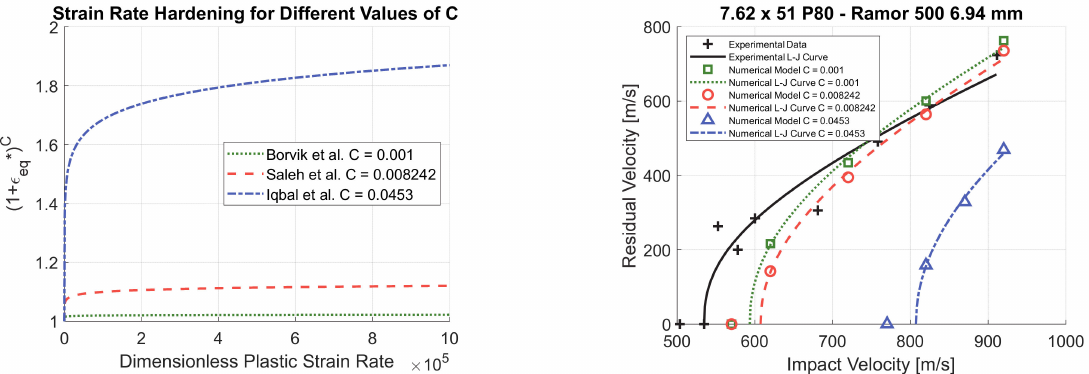
Figure 9. Strain rate hardening for different values of C ( a ) and C parametric study ( m = 0.84) ( b ). The values reported in the literature for the parameter m vary in the range between 0.84 and 1.045 [1,28,29,44]. As shown in Figure 10a, the thermal softening remains largely unaffected if the parameter m remains within this range. Considering the maximum and the minimum value of m , the maximum difference in the thermal softening rule (1 − T m ) is 12% and is obtained at T* = 0.34. Therefore, the perforation resistance predicted by the numerical model is slightly affected by the value of m , as shown in the parametric study of Figure 10b. The perforation resistance slightly decreases if the value of m decreases. The highest accuracy is obtained with the value of m = 0.84, determined by Iqbal et al. [29].